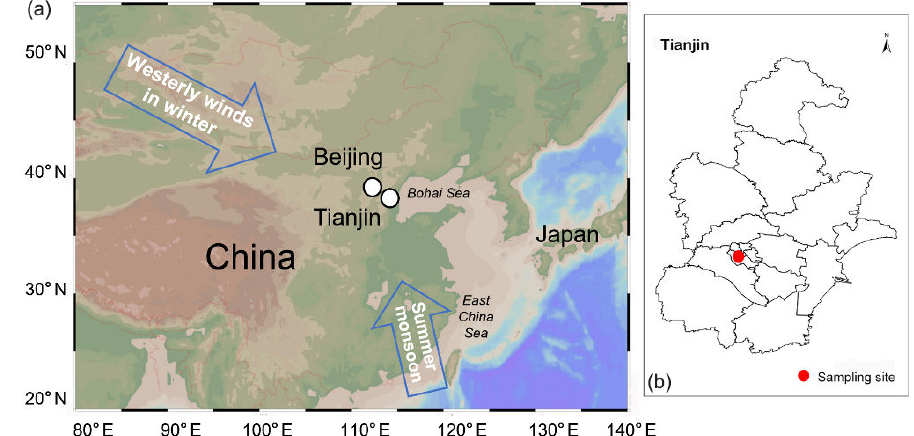
Figure 1. Map showing the location of Tianjin city (a) and the sampling site (b) in the Nankai district, Tianjin (the map is from Ocean Data